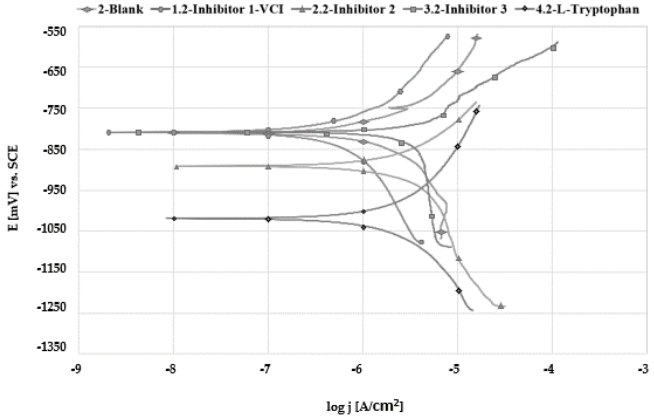
Figure 5. Polarization curves of tested inhibitors, compared to unprotected galvanized steel in distilled water.